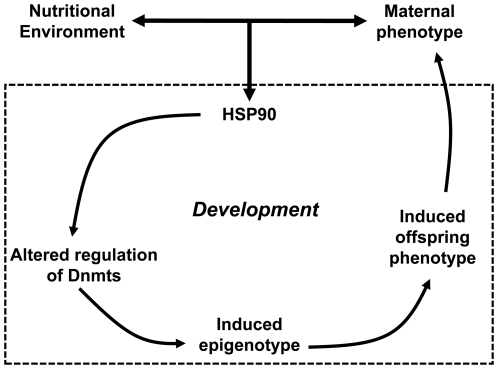
Scheme for induction of phenotypic and epigenetic variation between generations.